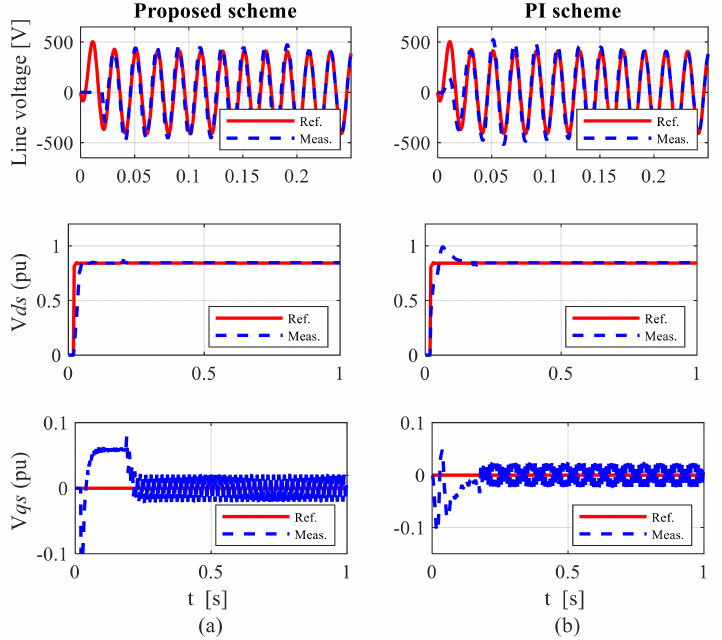
Figure 13. Control performances during super-synchronous speed operation under unbalanced grid conditions for R r(perturbed) = 50% R r : ( a ) proposed scheme and ( b ) PI scheme.